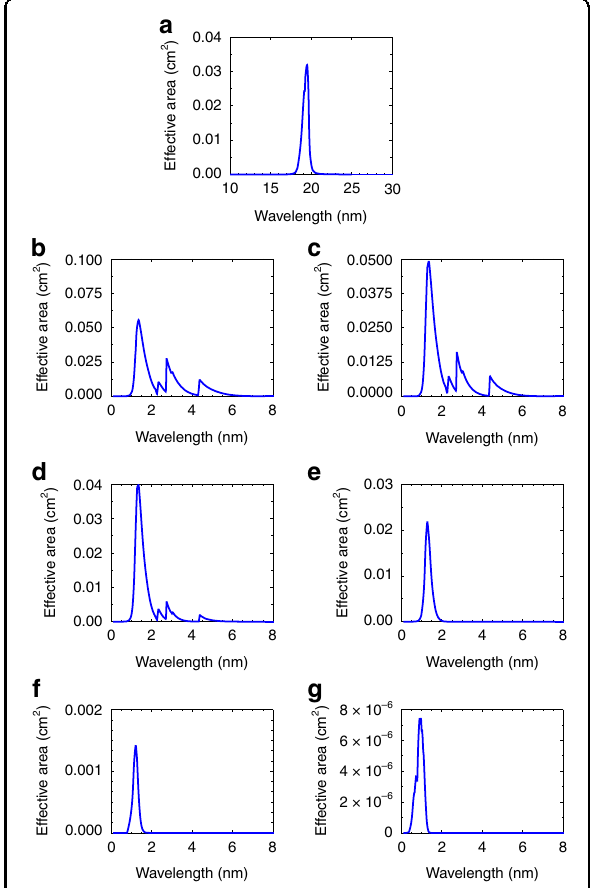
Fig. 12 Effective area distributions of X-EUVS. a EUV band, b X1 band, c X2 band, d X3 band, e X4 band, f X5 band, and g X6